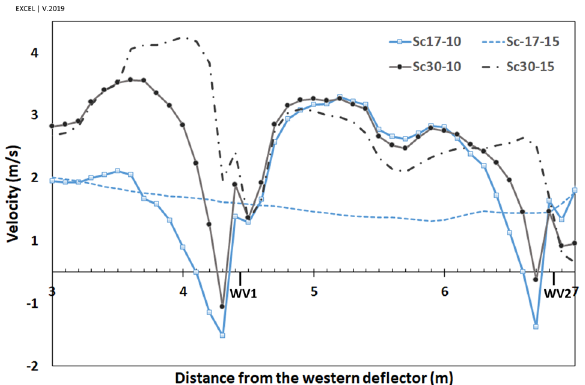
Figure 20. Microscale eddies near WV1 and WV2 behind the western deflector.